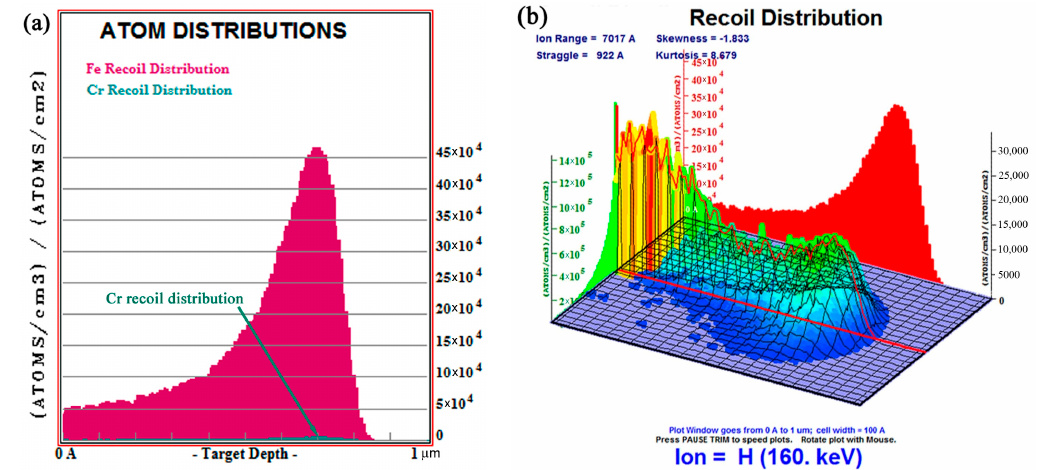
Figure 3. Distribution of the transport and damage position of H + protons on the surface layer of tempered 5140 alloy steel: ( a ) distribution of Fe and Cr recoil atoms along the depth of incidence, ( b ) three-dimensional distribution of vacancies formed by Fe, Cr recoil atoms, and H + proton irradiation along the depth of incidence.